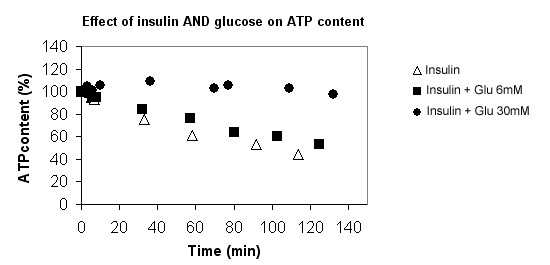
Time course of the change in hepatic ATP content throughout the entire protocol perfusion in presence of insulin. The results are presented for three typical individual experiments: insulin alone (group D), insulin + 6 mM glucose (group E) and insulin + 30 mM glucose (group F). The results are expressed as the percentage of initial ATP content, 100% being the value at the onset of the experiment. Note that in the control KHB group, the 6 mM glucose group and the 30 mM glucose group, the ATP content decreased at a similar rate to the insulin group.